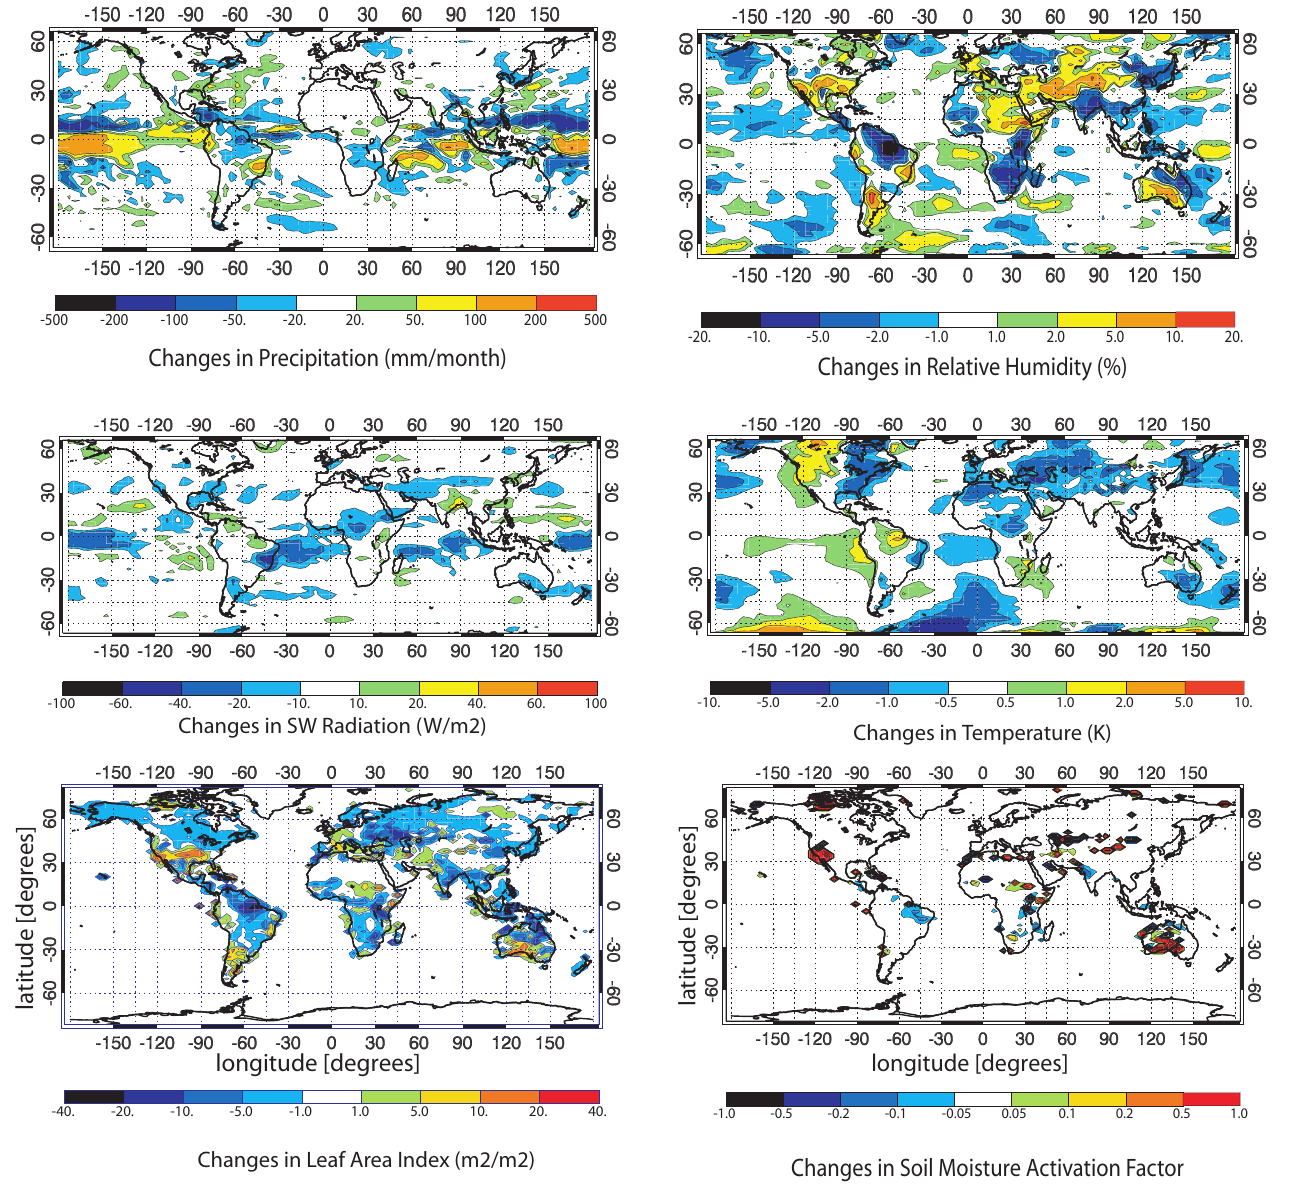
Fig. 3. Differences, between 1992 and 1990, of drivers of isoprene emissions and selected diagnostics from the isoprene emissions calcula-